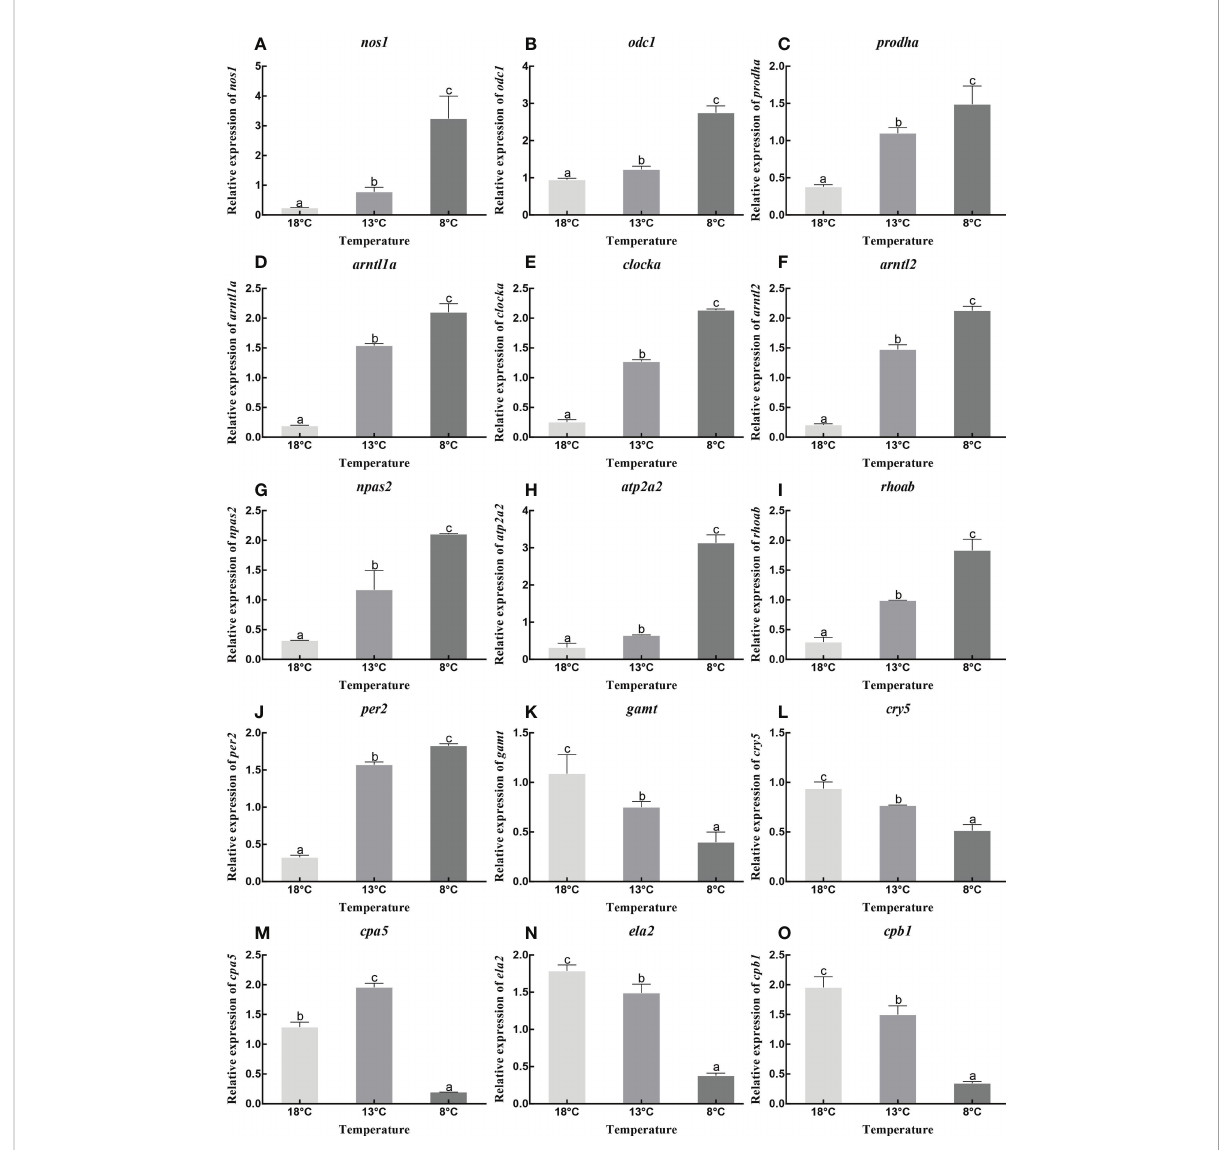
FIGURE 5 Relative expression of nos1 (A) , odc1 (B) , prodha (C) , arntl1a (D) , clocka (E) , arntl2 (F) , npas2 (G) , atp2a2 (H) , rhoab (I) , per2 (J) , gamt (K) , cry5 (L) , cpa5 (M) , ela2 (N) and cpb1 (O) under different temperature. Data were presented as the mean ± SEM. Different letters indicate signi fi cant differences between groups ( P